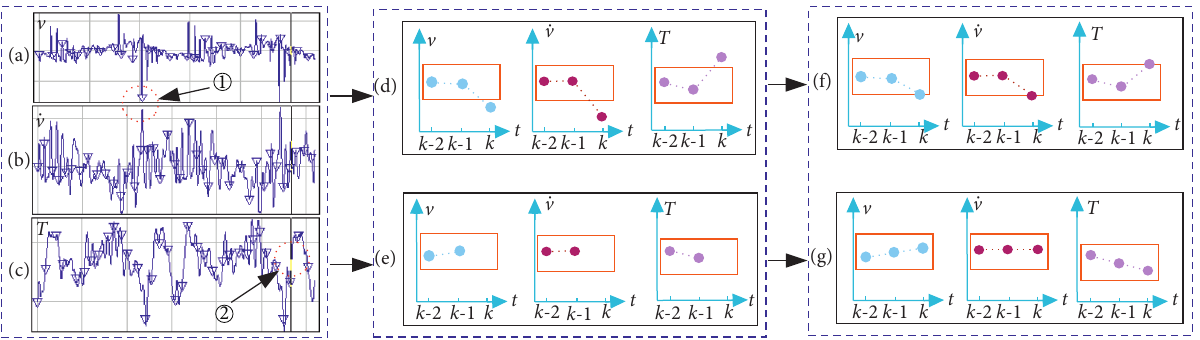
Figure 3: The flow diagram of the sliding-mode-based